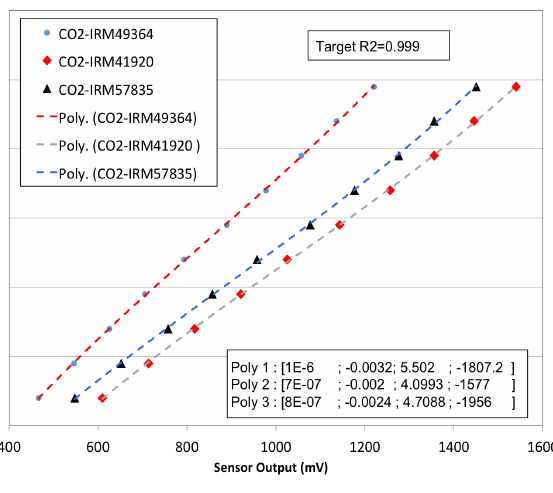
( a ) Voltage measurements before calibration.